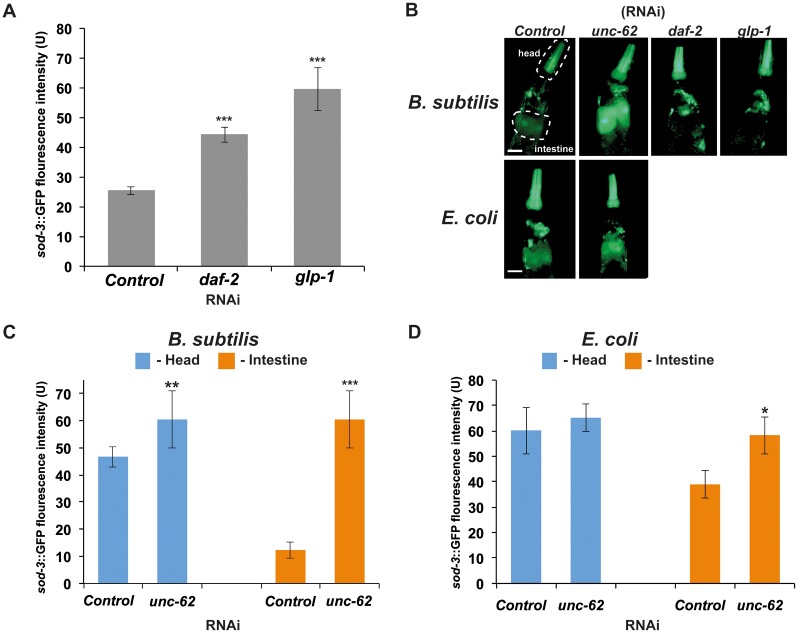
Consequences of daf-2 (RNAi), glp-1 (RNAi), and unc-62 (RNAi) on sod-3 expression.(A) sod-3::GFP expression is increased in daf-2 (RNAi) and glp-1 (RNAi) treated animals. RNAi was induced at L4 larval stage by feeding worms B. subtilis expressing dsRNA. sod-3::GFP expression was measured at day 2 of adulthood. The y-axis denotes GFP expression (arbitrary units). Average expression and Standard Error from 20 animals are shown. (B) Representative pictures of expression of sod-3::GFP at day 2 of adulthood in unc-62 (RNAi), daf-2 (RNAi) and glp-1 (RNAi) treated animals. The dashed lines indicate areas where fluorescence intensity was quantified to measure GFP intensity in the head or intestine (dashed lines in representative pictures (B) indicate the areas used in quantifications) upon RNAi treatment. sod-3::GFP expression is increased in the intestine of unc-62 (RNAi) treated animals. RNAi was induced starting at L4 larvae stage by feeding worms (C) B. subtilis or "(D) E. coli bacteria expressing dsRNA. *-p-value < 0.05, **- p-value >< 0.01, and **-p-value ><0.001 (t-test p-values). Scale bar = 50μm.